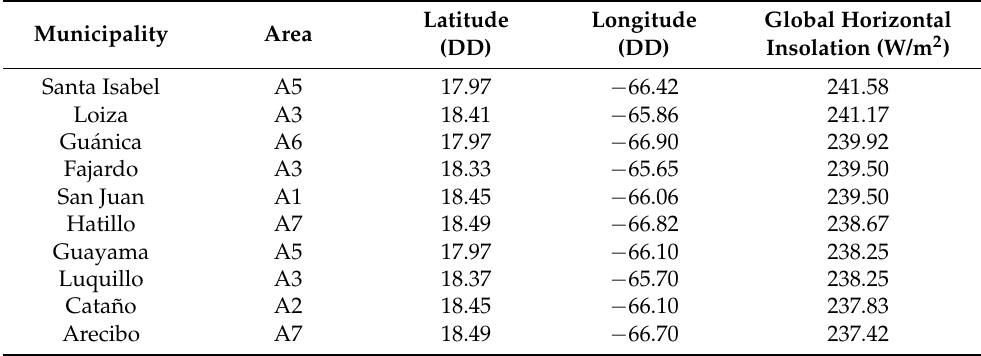
Table 5. Top 10 list of the municipalities with the highest average daily global insolation per year (Data from